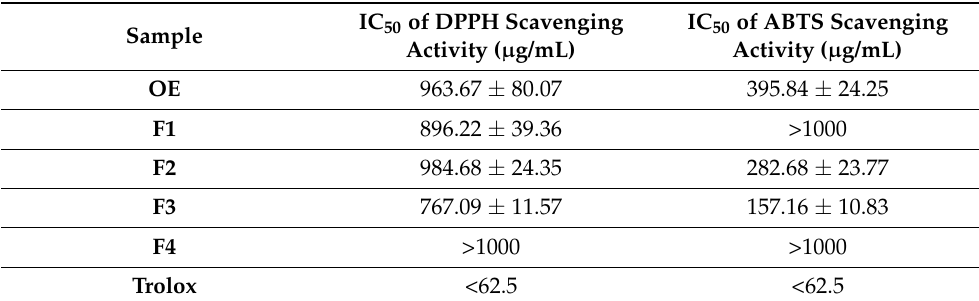
Table 4. IC 50 values of DPPH and ABTS radical-scavenging activity of OE and F1 – F4 obtained from E . cavolini . Trolox was used as positive